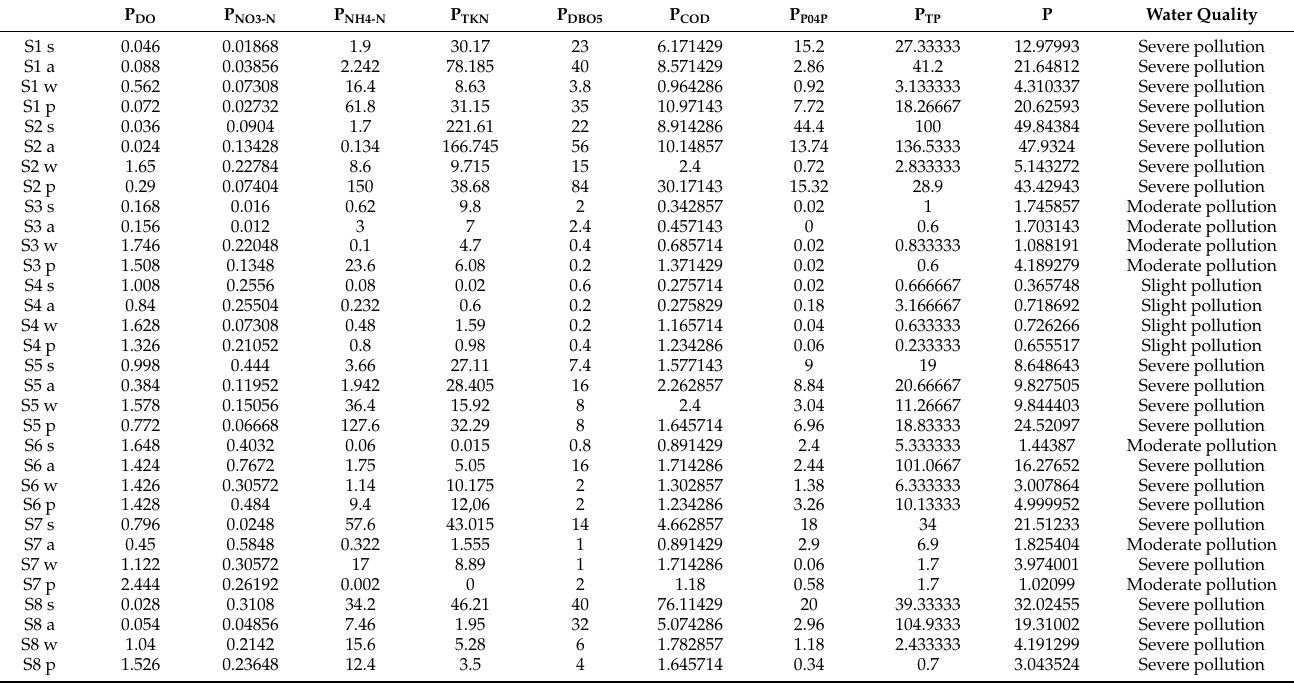
Table 4. Pollution index of each parameter and global pollution index of eight sampling